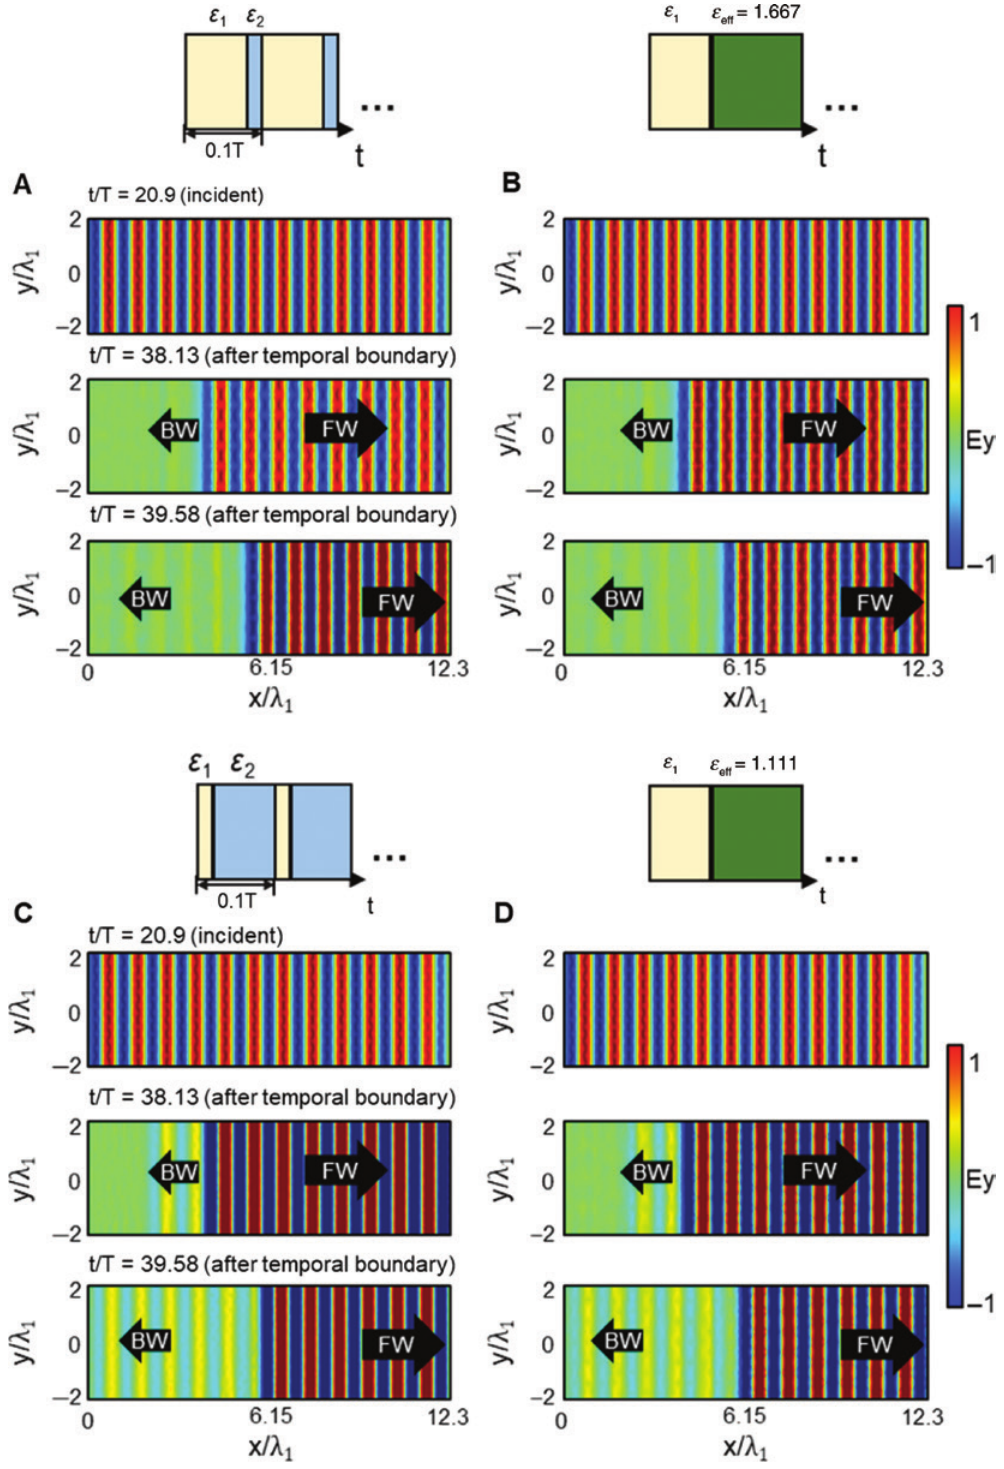
= 2. 1 = 2 and ε = 1) or in a single step (from ε = 2 to ε ) at the normalized time t/T = 37.3 1 2 1 eff = 1.667 (B) and ε = 1.111 (D). For these results, the incoming signal is eff eff